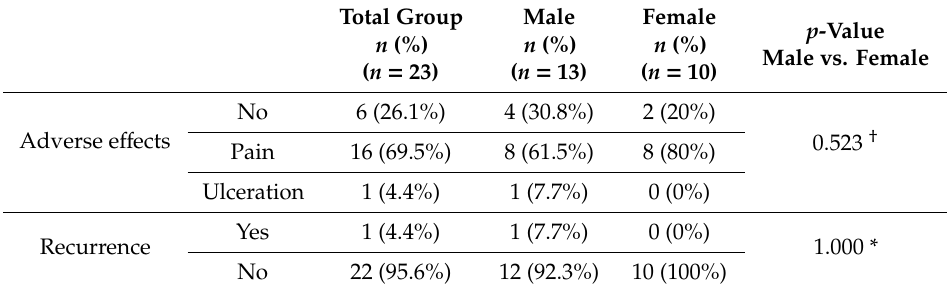
Table 3. Clinical features of the sample population at one month after intervention. Total